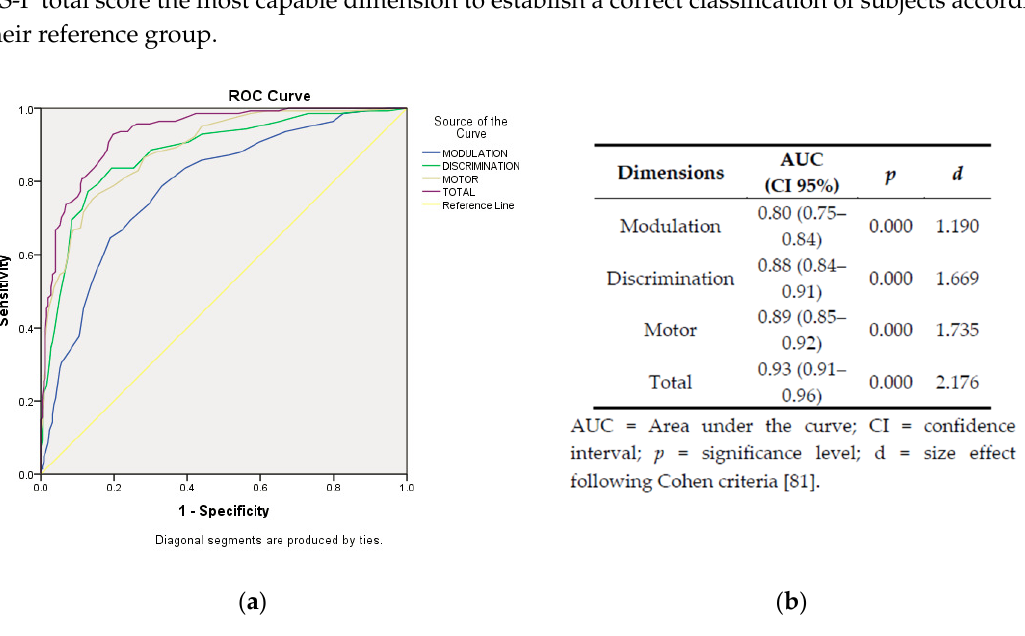
Figure 3. Graphical representation ( a ) and statistics ( b ) from the receiver operating characteristic (ROC) curves. Table 5. Combination of the level of affectation in the Rivière’s Inventory and the Behavioral Observation on Sensory Stimuli Questionnaire for Parents’ (BOSS-P) interquartile scores.